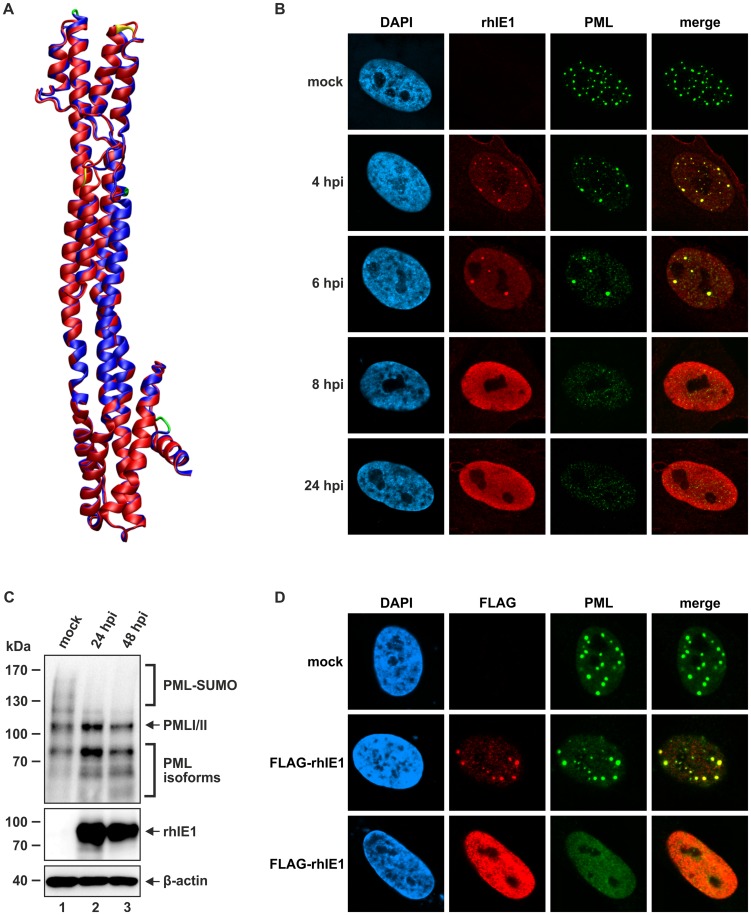
Structural and functional similarity between hIE1 and rhIE1.(A) Homology model of hIE1 (blue) superimposed onto the rhIE1 template crystal structure (red). The insertions (green) and deletions (yellow) of hIE1 compared to rhIE1 are mainly located in loop regions and do therefore not disrupt the secondary structure elements. Structure validation using ProSA indicates that the model exhibits a good global and local quality and the respective structural parameters are close to that of the template crystal structure (Figure S7) suggesting that hIE1 and rhIE1 adopt a highly similar fold. (B) Dispersal of PML-NBs after RhCMV infection of primary human fibroblasts (HFFs). HFF cells were infected with RhCMV at an MOI of 0.1 and harvested at indicated times for immunofluorescence analysis of rhIE1 and endogenous PML. Cell nuclei were counterstained with DAPI. (C) DeSUMOylation of PML after RhCMV infection of HFF cells. Cell lysates harvested either from mock infected cells or from cells infected with RhCMV at an MOI of 3 for indicated times (24, 48 h) were separated by SDS-PAGE and analyzed by Western blotting for expression of PML (upper panel), rhIE1 (middle panel) and β-actin as internal loading control (lower panel). (D) Dispersal of PML-NBs after transient expression of rhIE1 in HFFs. HFFs were transfected with a eukaryotic expression vector encoding rhIE1 fused to an N-terminal FLAG-tag and, after 48 h, subjected to indirect immunofluorescence analysis of rhIE1 using an anti-FLAG antibody and of endogenous PML; cell nuclei were stained with DAPI. Upper panel: mock transfected cells. Middle panel: colocalization of rhIE1 and PML, as observed in only few transfected cells. Lower panel: dispersed pattern of rhIE1 and PML, as observed in the majority of transfected cells.